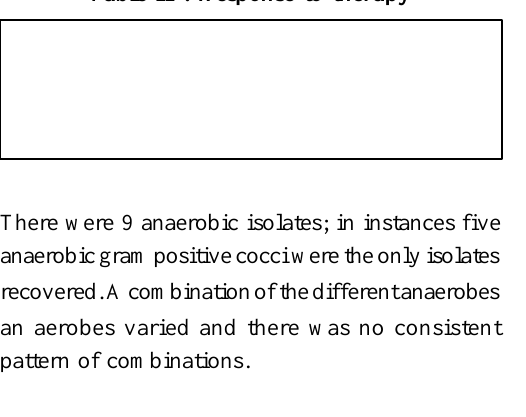
Table II : Response to